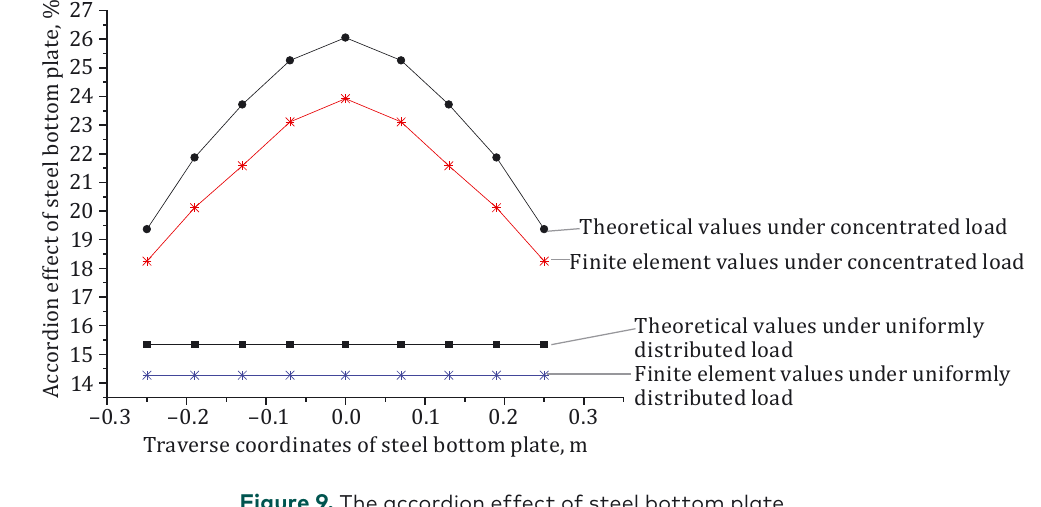
valuesCalculated values of finite element method Calculated values of elementary beam theory Calculated values of this paper's Test